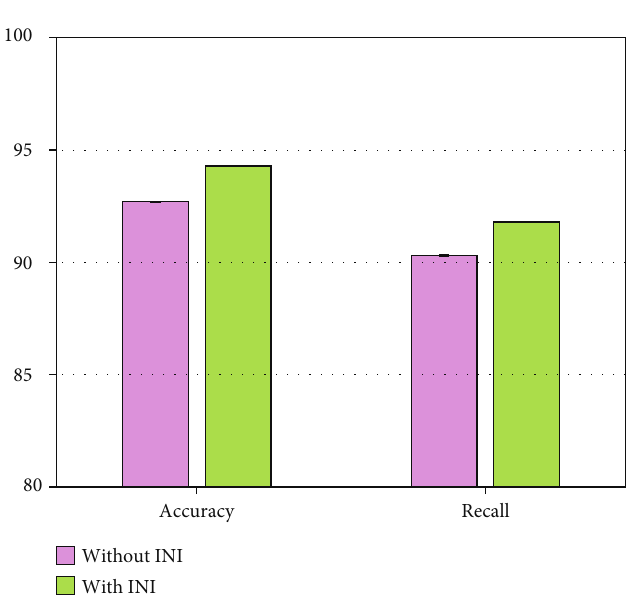
Figure 5: Evaluation on INI strategy.